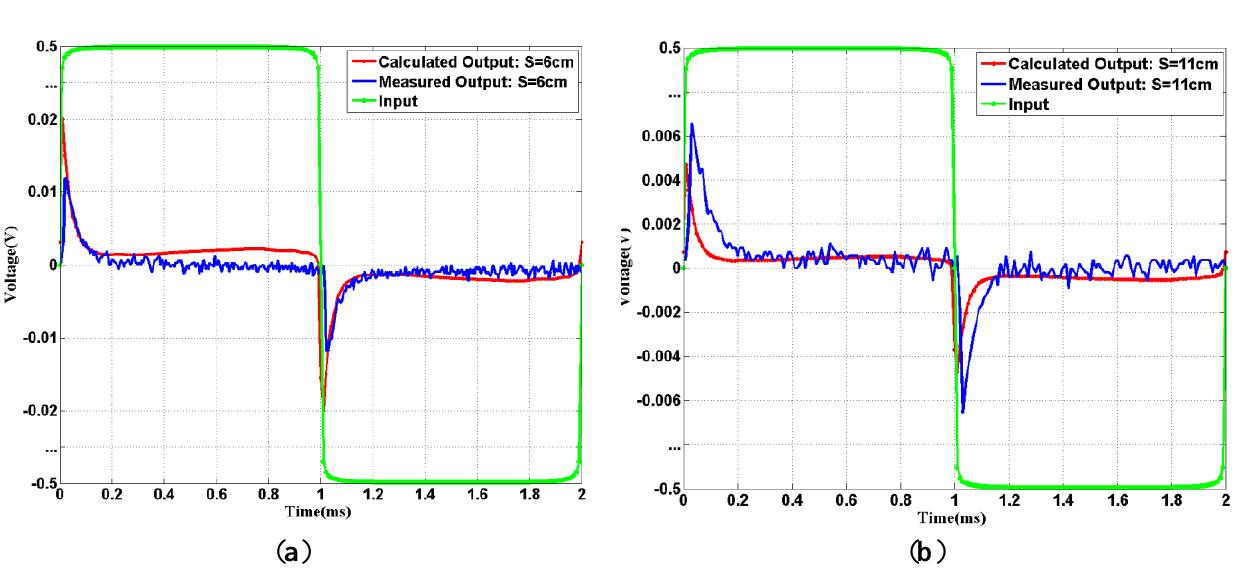
Figure 6. Input and Output of baseband IBC transmission for 500 Hz square